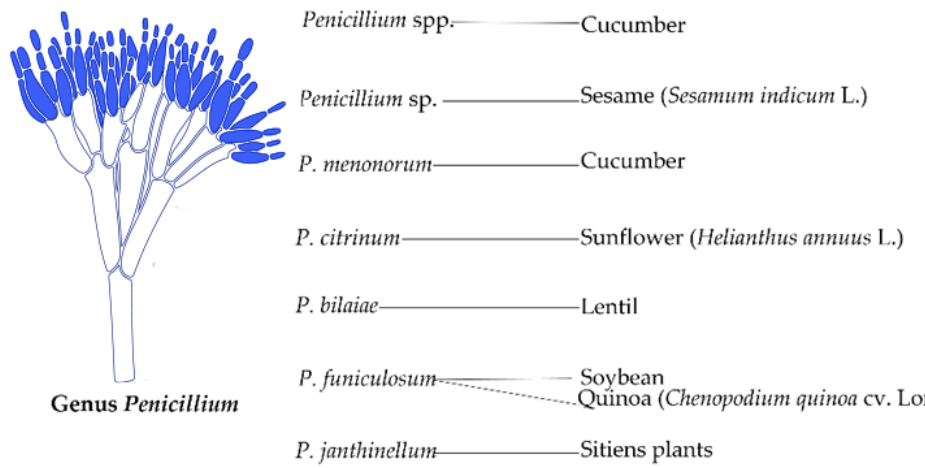
Figure 2. Species of the genus Penicillium used in the promotion of plant growth.